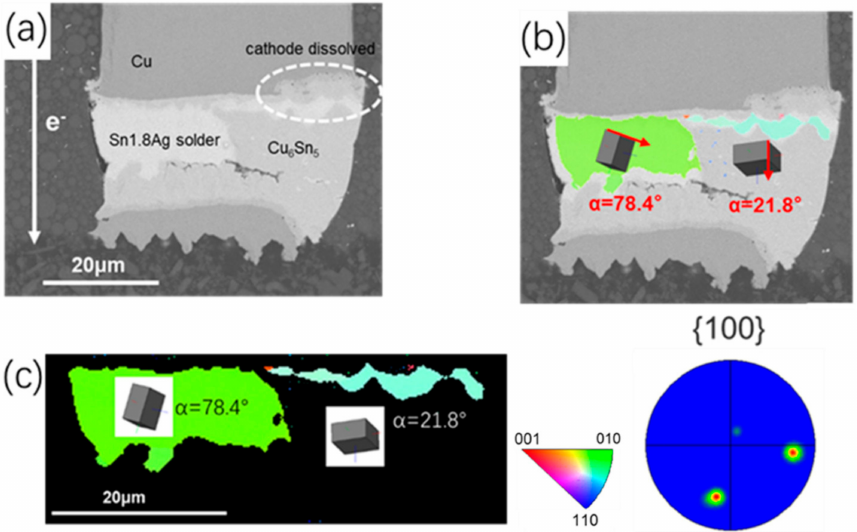
Figure 3. Microstructure after current stressing at 1.5 × 10 4 A/cm 2 at 125 ◦ C for 200 h: ( a ) SEM image for the bump with downward electron flow; ( b ) SEM image for the bump with downward electron flow with unit cells; ( c ) the EBSD image corresponding to ( a ).